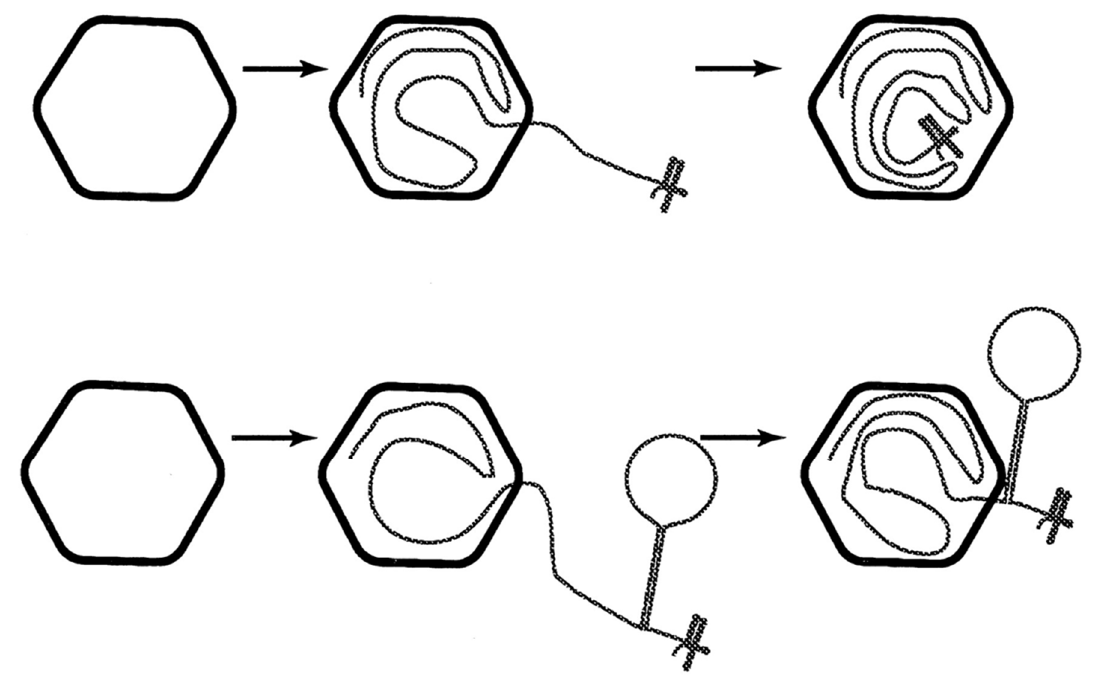
Figure 8. Model showing that the packaging process of ssRNA segment with strong hairpin near the 3 ′ end can block the process. The exposed hairpin structure becomes vulnerable to RNase I digestion. Reproduced from Qiao et al. (1995).